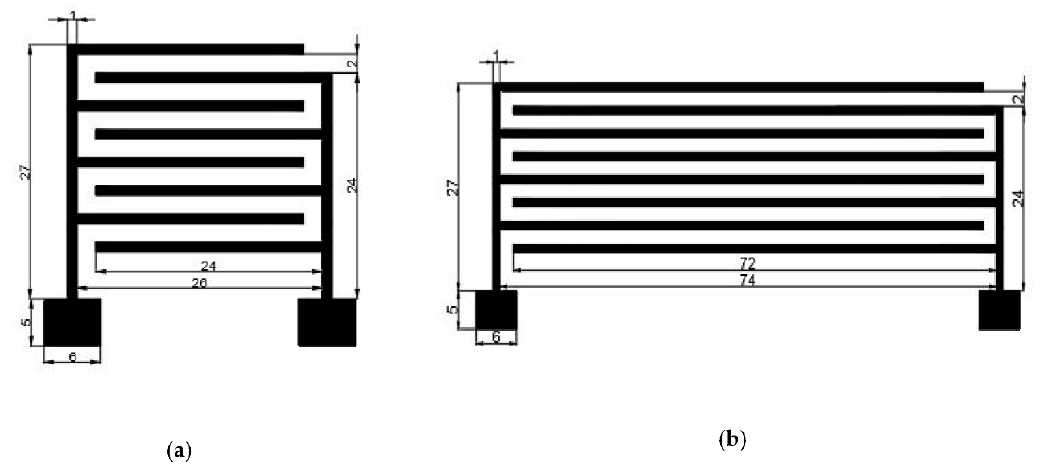
Figure 1. Layout and dimension detail of the proposed moisture sensor (in mm): ( a ) short sensor; ( b ) long sensor. The bottom squares correspond to the characterization pads.